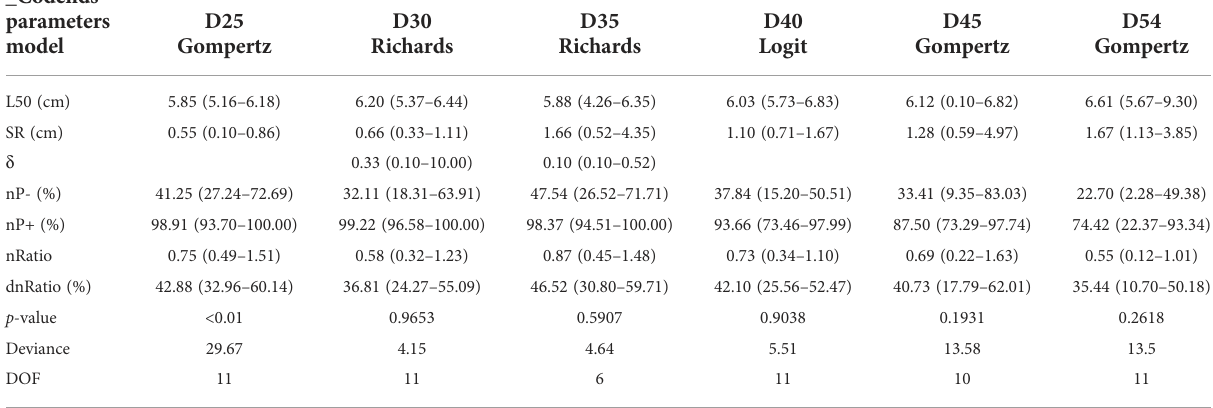
TABLE 4 Selective parameters, fi t statistics, and performance indicators obtained from the selected models for the codends